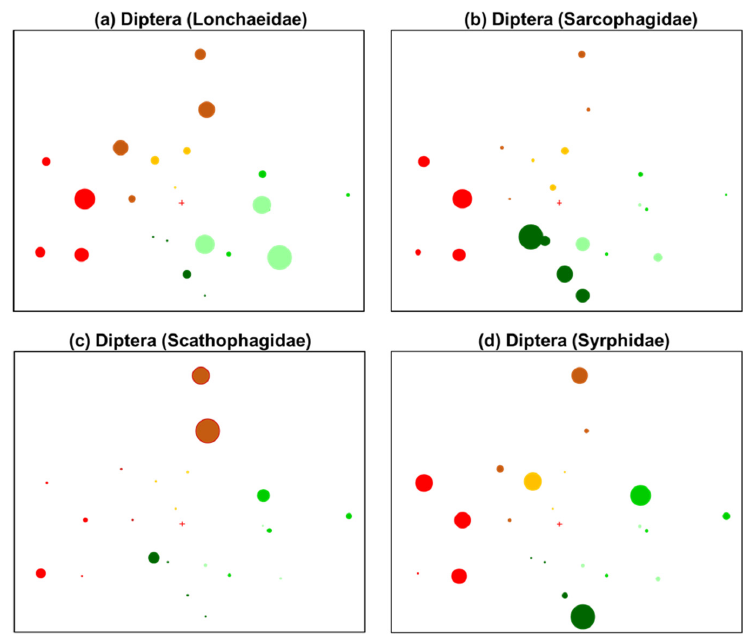
Figure 9. NMDS ordination results for neutral-response Diptera in burn and reference study sites. Panels ( a – d ) show results for Diptera Families; ( a ) Lonchaeidae, ( b ) Sarcophagidae, ( c ) Scathophagidae, ( d ) Syrphidae. Symbol size is scaled by percent abundance within each sample.